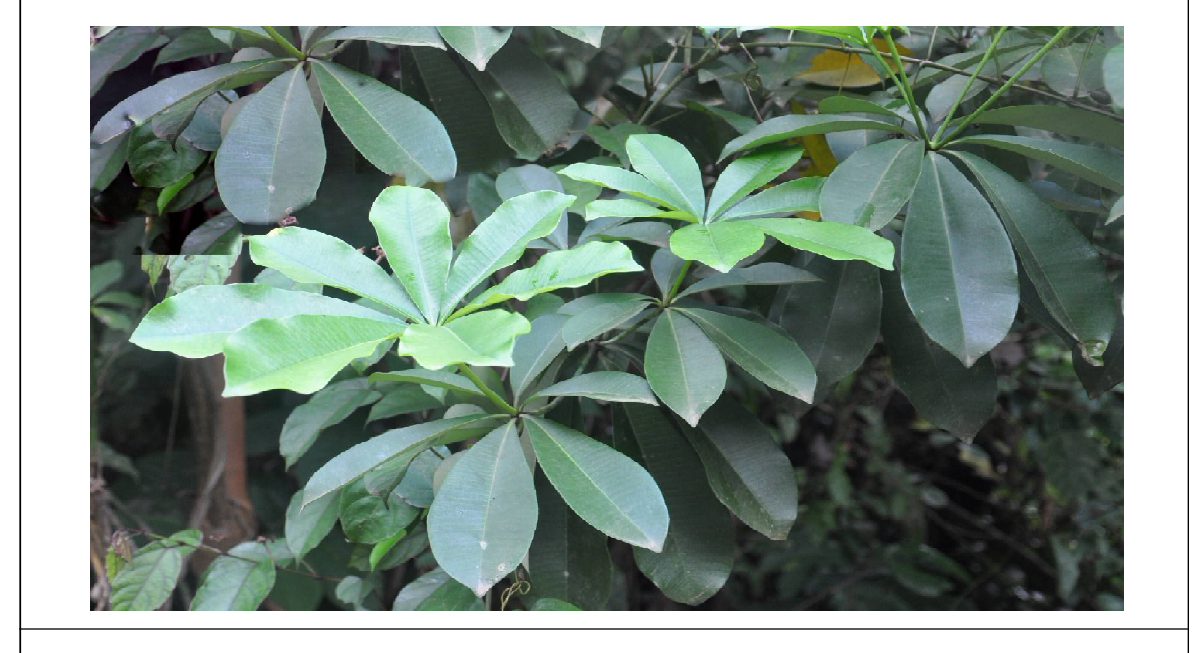
Figure 1: Leaves of A. boonei (Siepel et al .,